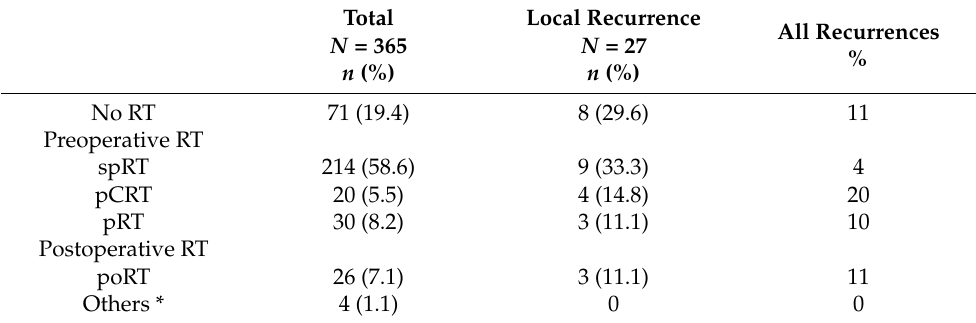
Table 2. Local recurrence according to type of